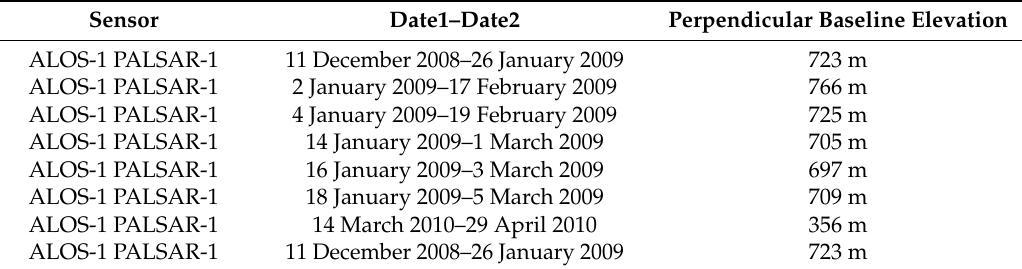
Table 2. List of ALOS PASAR scenes used for processing of fringes.